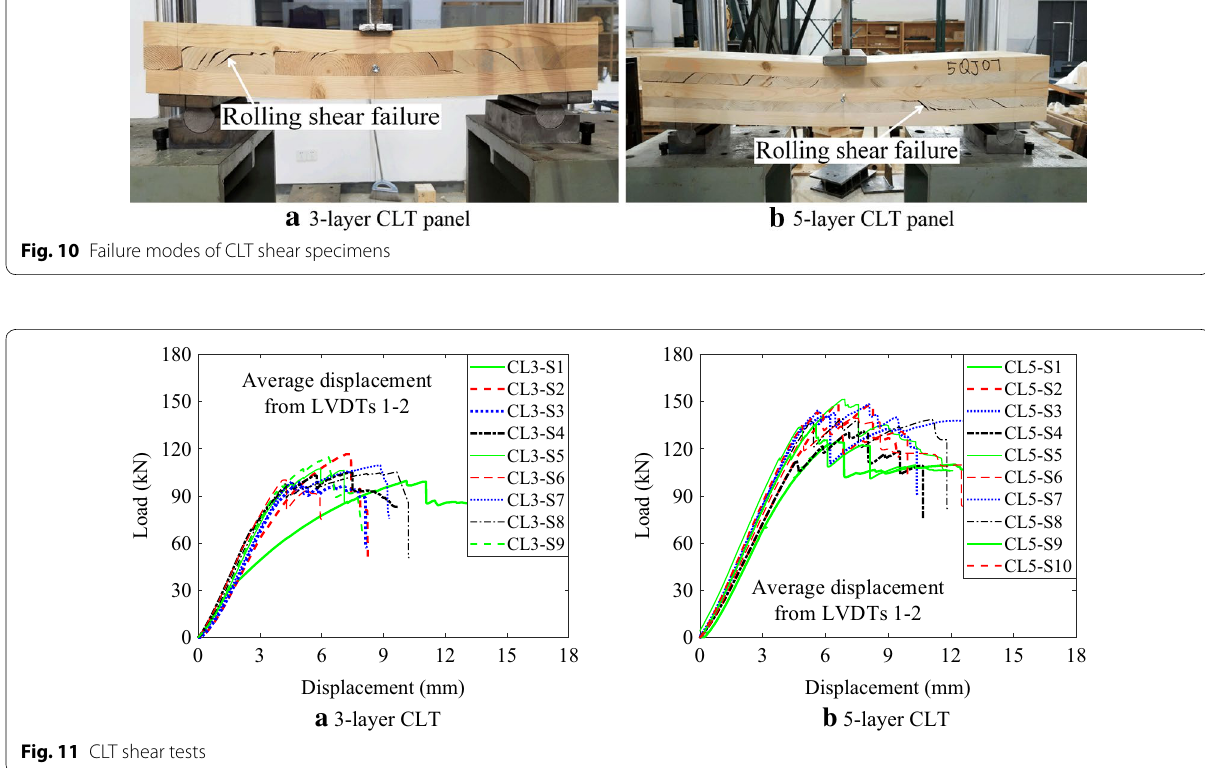
Fig. 11 CLT shear